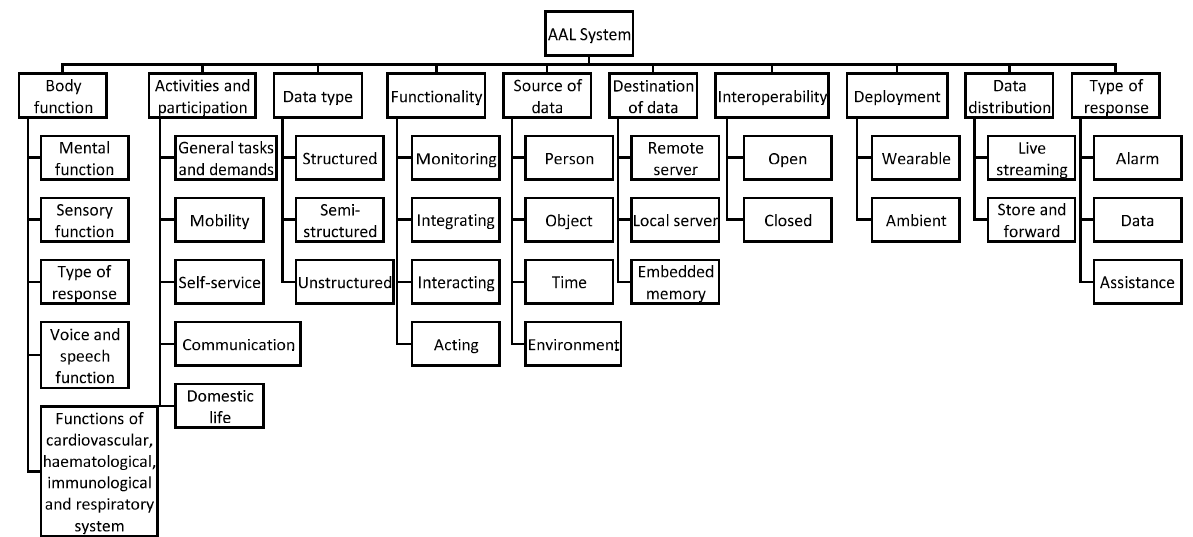
Figure 2. AAL functional services classification (adapted from [38] (p. 4)).